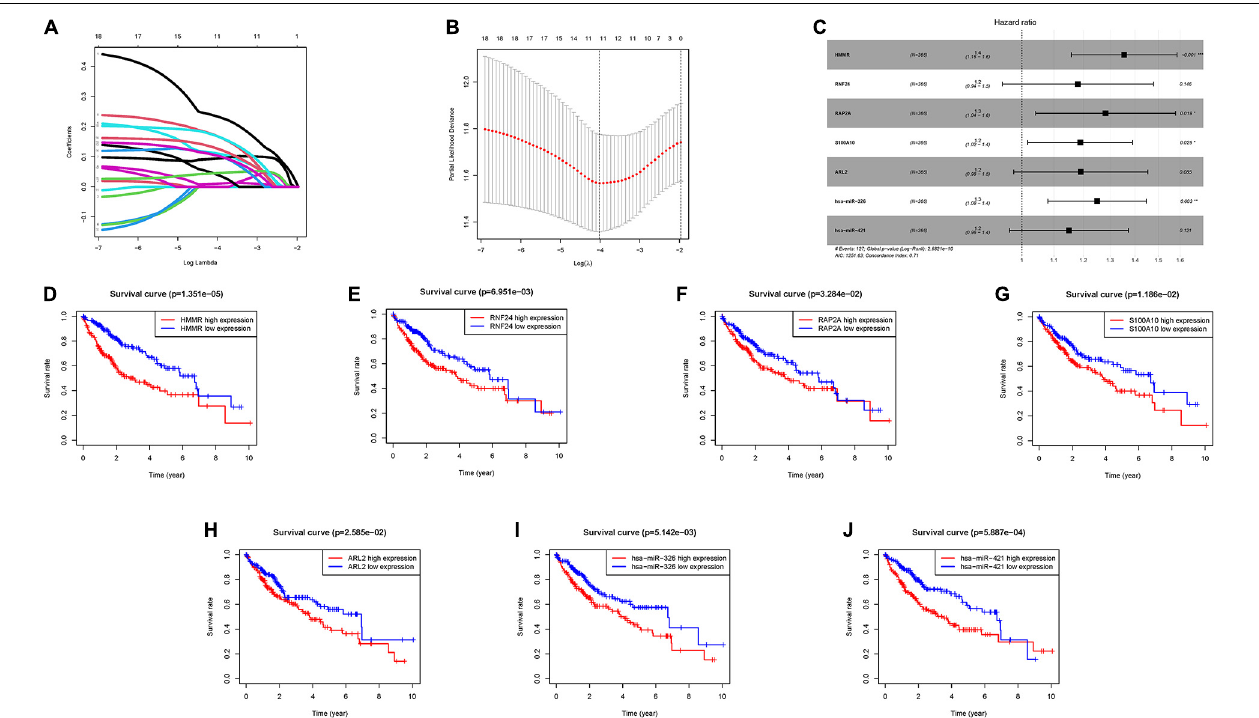
FIGURE 3 | Establishment of the prognostic risk signature. (A) LASSO coefficient profiles of 36 candidate genes. A vertical line is drawn at the value chosen by 10-fold cross-validation. (B) Ten-time cross-validation for tuning parameter selection in the LASSO regression. The vertical lines are plotted based on the optimal data according to the minimum criteria and 1-standard error criterion. The left vertical line represents the 11 genes finally identified. (C) Forest plots showing the relationships of each gene subsets with OS. The unadjusted HRs are presented with 95% CIs. (D) K-M curve analysis presenting difference of OS between the high-HMMR and low-HMMR groups. (E) K-M curve analysis presenting difference of OS between the high-RNF24 and low-RNF24 groups. (F) K-M curve analysis presenting difference of OS between the high-RAP2A and low-RAP2A groups. (G) K-M curve analysis presenting difference of OS between the high-S100A10 and low-S100A10 groups. (H) K-M curve analysis presenting difference of OS between the high-ARL2 and low-ARL2 groups. (I) K-M curve analysis presenting difference of OS between the high-hsa-miR-326 and low-hsa-miR-326 groups. (J) K-M curve analysis presenting difference of OS between the high-hsa-miR-421 and low-hsa-miR-421